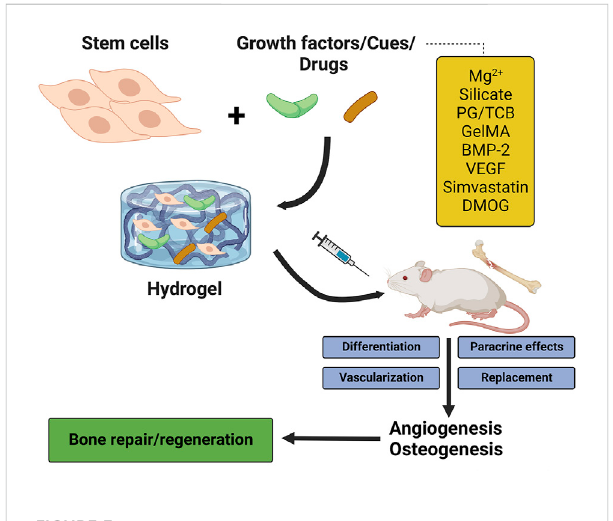
FIGURE 3 The stimulatory effects of hydrogels on osteogenesis and angiogenesis. PG/TCB, poly ethylene glycol maleate citrate (PEGMC) with β -TCP; GelMA, gelatin methacrylate; BMP-2,